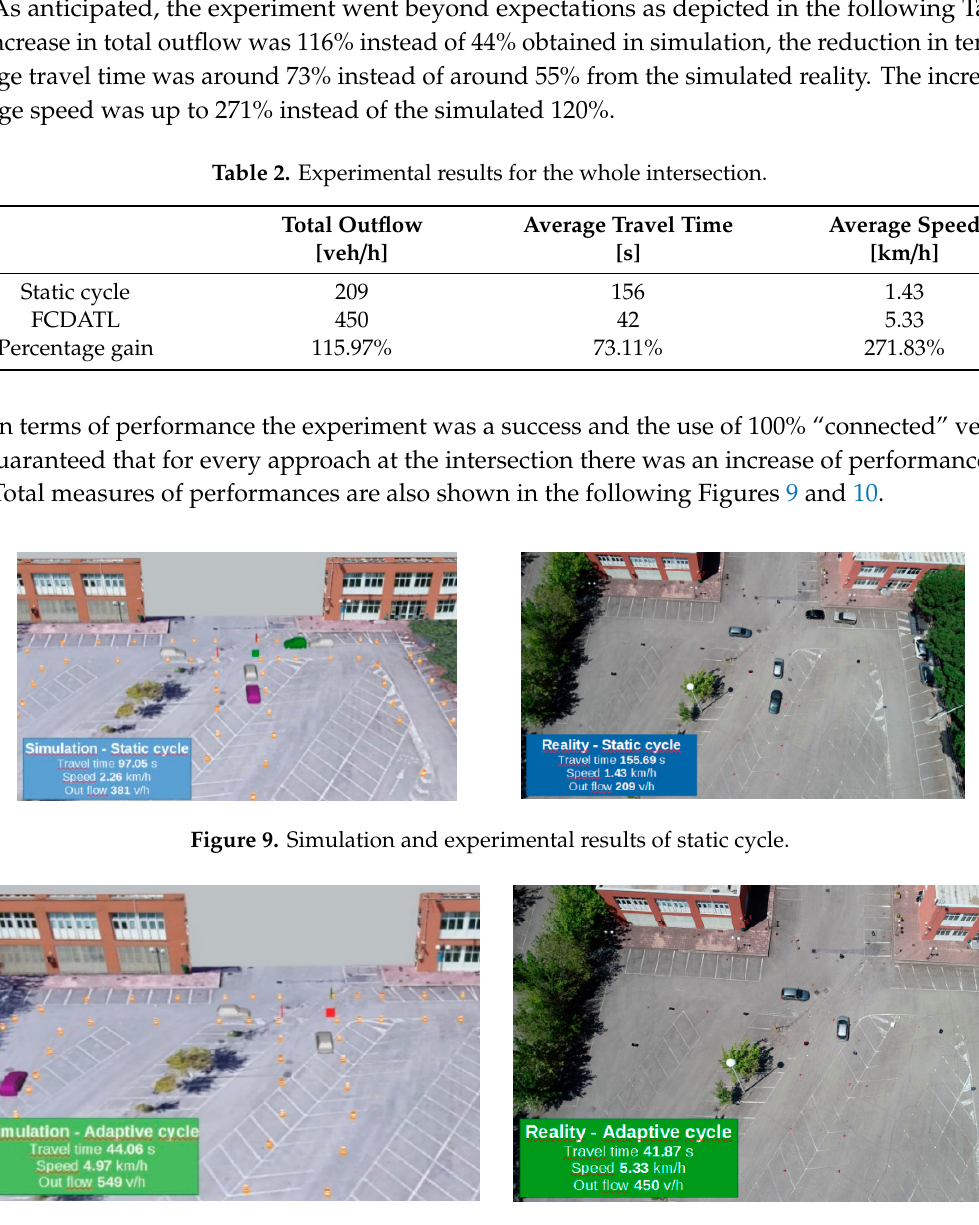
Figure 10. Simulation and experimental results of floating car data adaptive traffic signal (FCDATS).